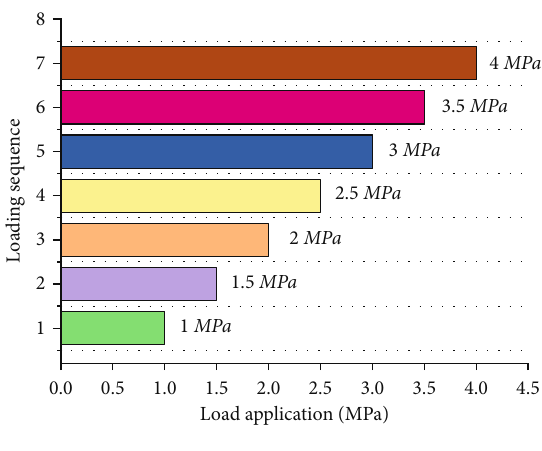
Figure 7: Loading